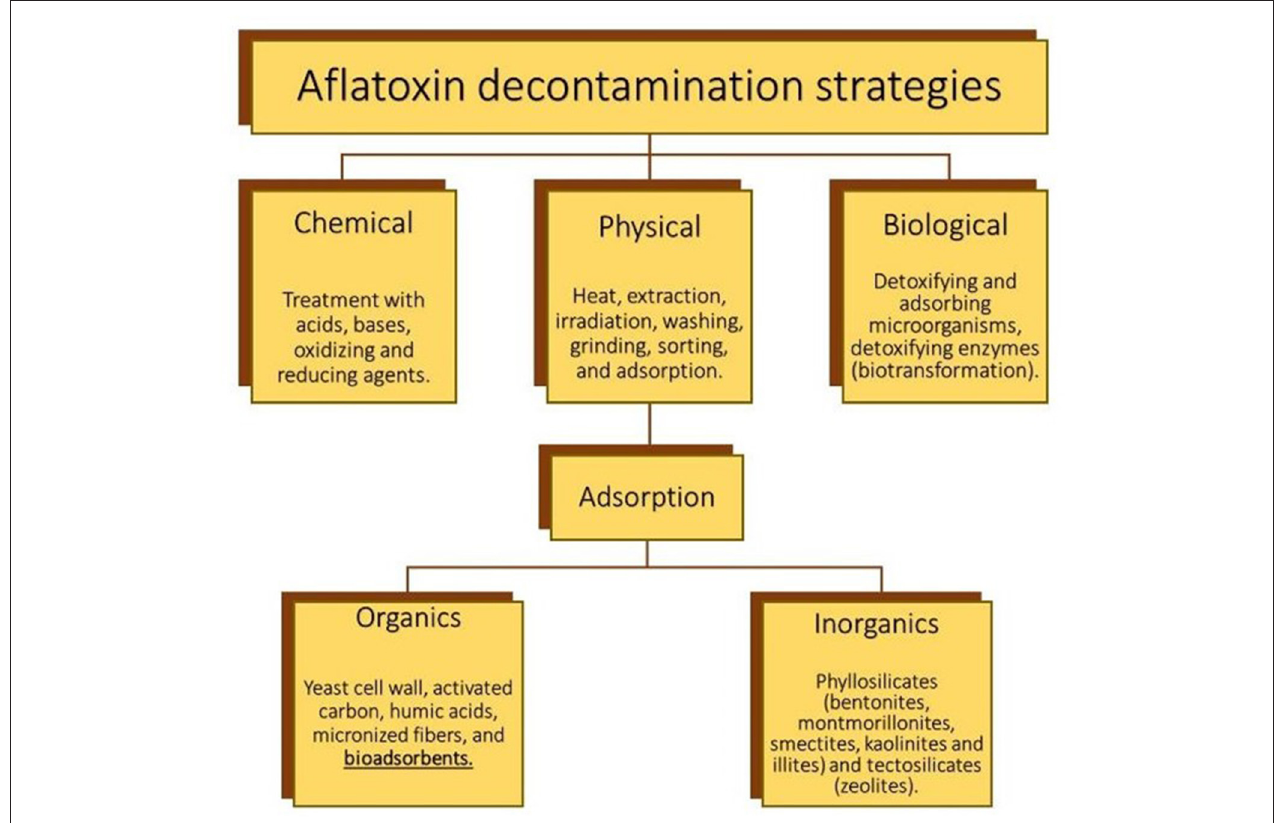
FIGURE 2 | The most important physical, chemical, and biological decontamination technologies for aflatoxin control. Created with BioRender.com.